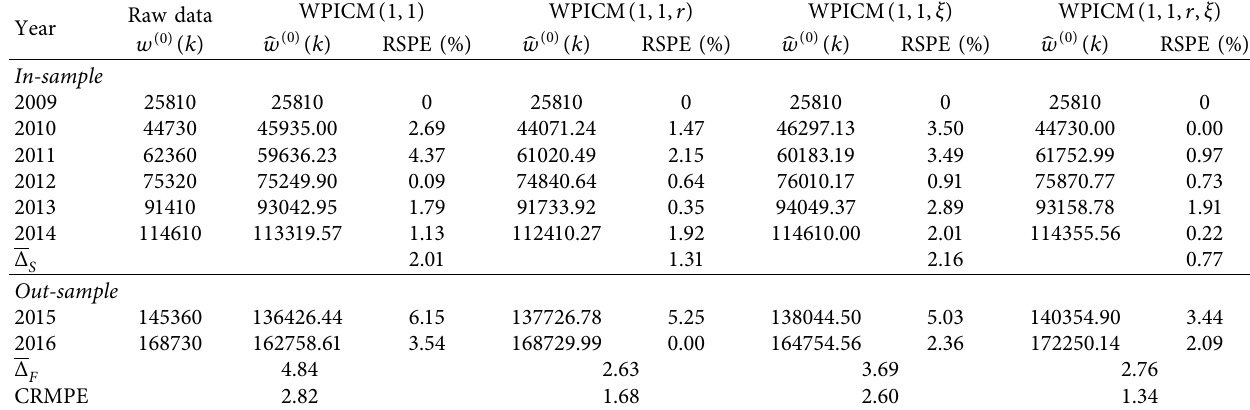
Table 2: Simulated/forecast results of wind power installed capacity with different